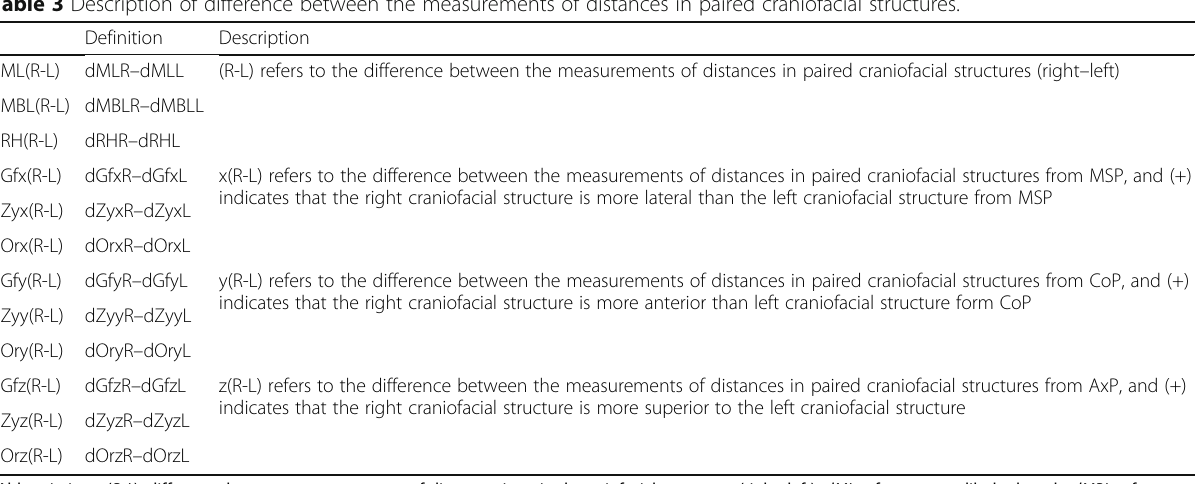
Table 3 Description of difference between the measurements of distances in paired craniofacial